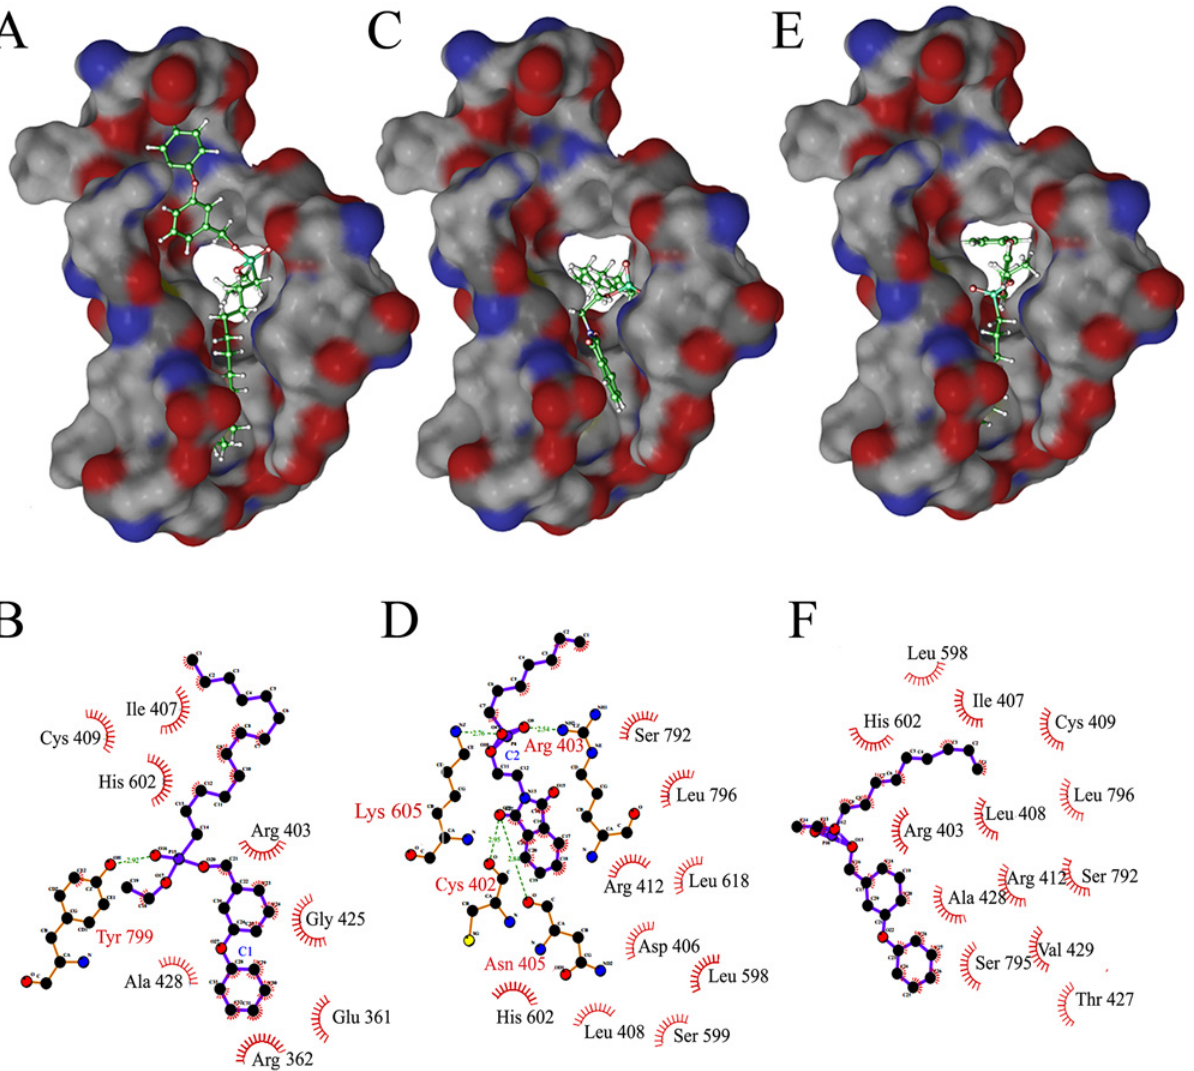
Fig 3. Docked Complex of Mtb DnaE2 with ChEMBL Database Compounds. Panels A, C, and E show the electrostatic surface potential of modeled Mtb DnaE2 with bound ligands (stick models, shown in atom colors). (A) 1-[[ethoxy(tetradecyl)phosphoryl]oxymethyl]-3-phenoxybenzene (C1), (C) 2- (1,3-dioxoisoindol-2-yl)ethoxy-heptylphosphinic acid (C2), (E) 1-[[ethoxy(nonyl)phosphoryl]oxymethyl]-3-phenoxybenzene (C3) respectively. In ligplot, Panels B , D, and F show 2D representation of ligand C1, C2, and C3 with the interacting amino acid residues of Mtb DnaE2. Green dashed lines indicate hydrogen bonds, with the numbers indicating the interatomic distances ( Å ). The labeled arcs with radial spokes that point toward the ligand atoms show the hydrophobic interactions with the corresponding amino acid